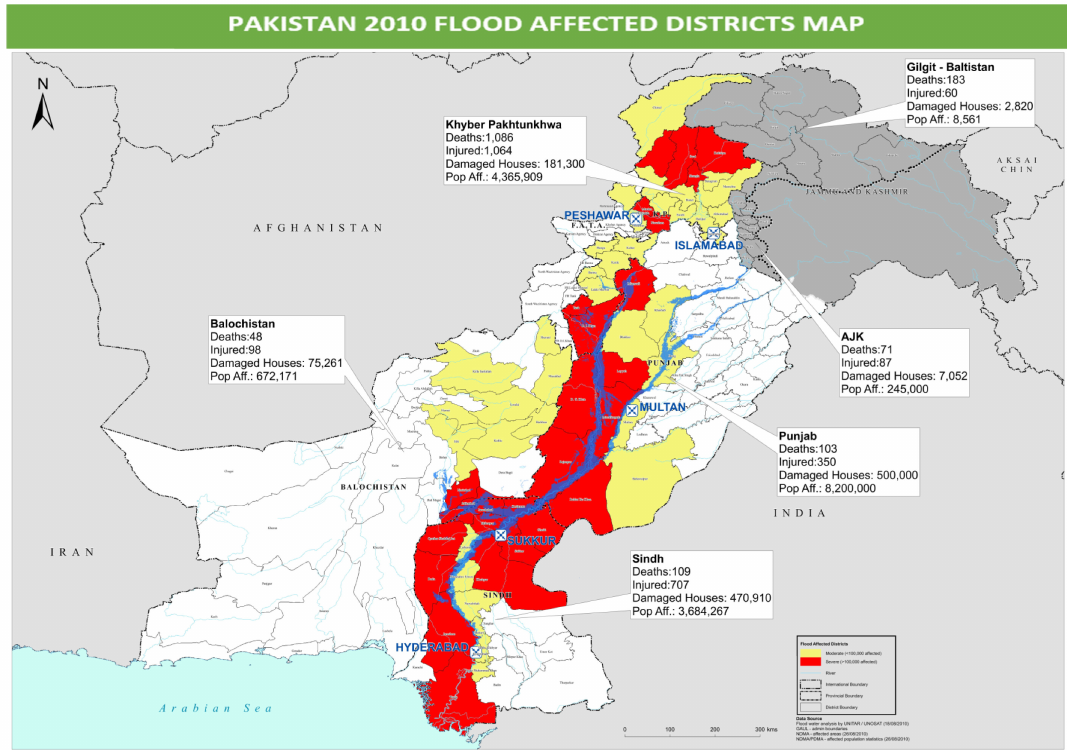
Figure 7. Map showing number of deaths, injuries, damaged homes, and affected population by province and region as of 30 August 2010. Source: 2010 Flood water analysis by OCHA